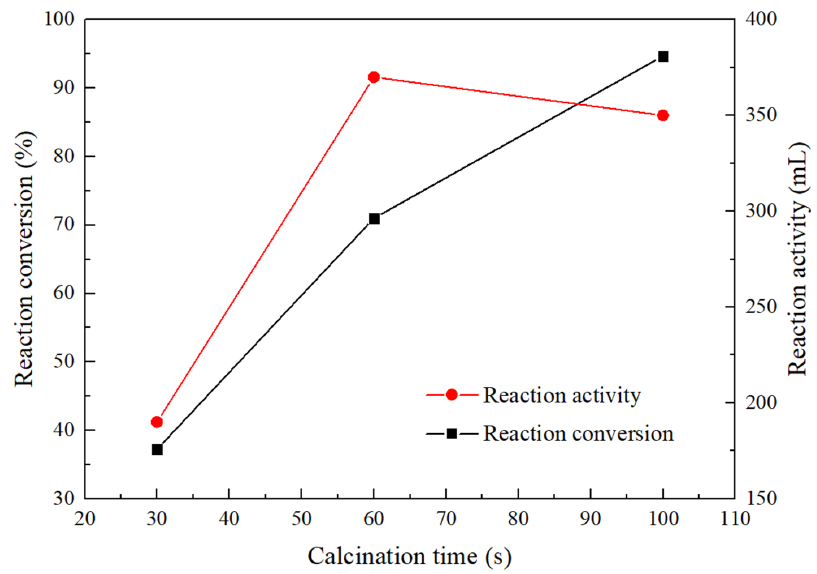
Figure 10. Conversion and activity of 0.68–1.0 mm limestone particles calcined at different